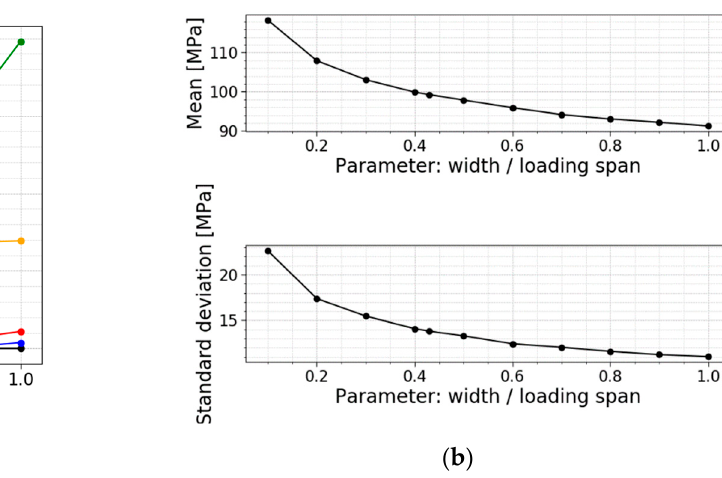
Figure 18. ( a ) AIC values and ( b ) the mean and st.dev. of the normal stress at failure for a varying ratio of the width to the loading span.